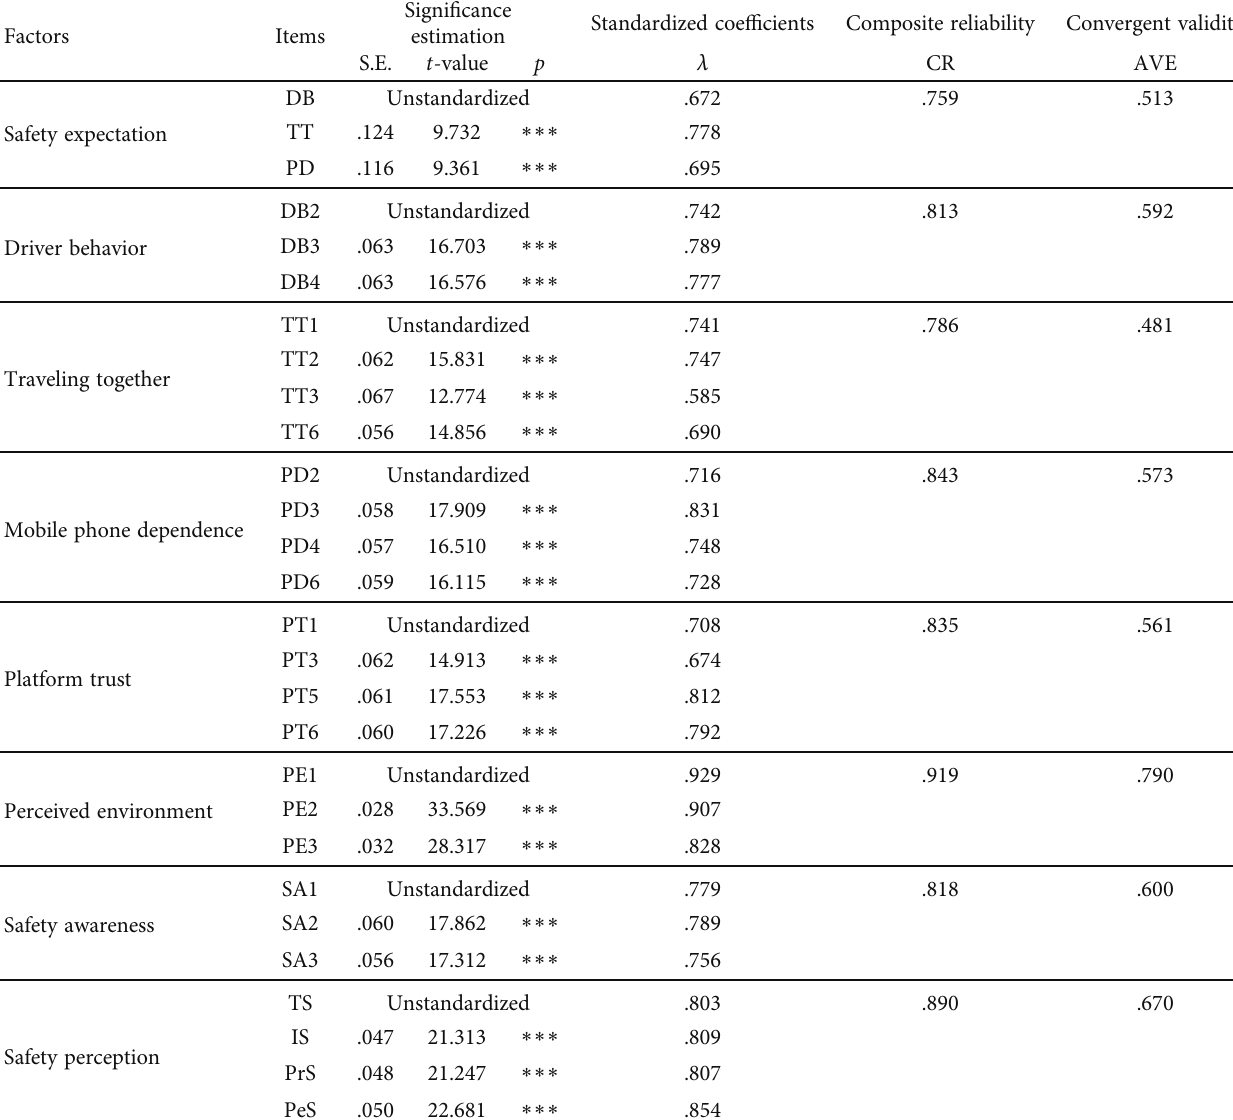
Table 5: The reliability and validity analyses of observed